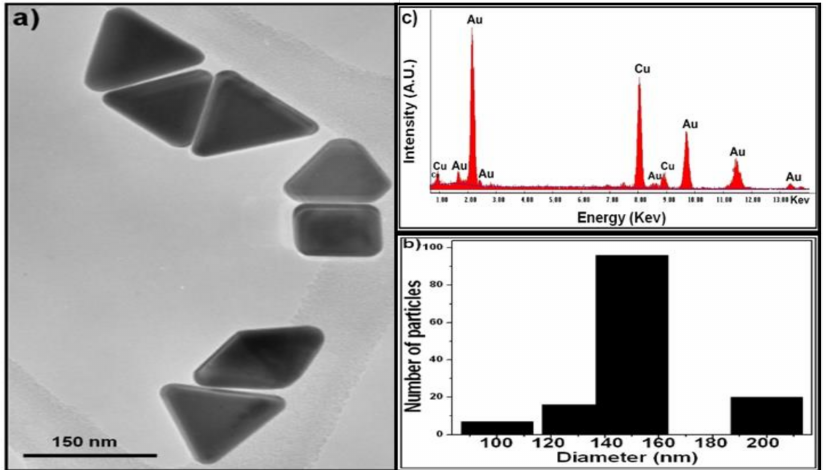
Figure 1. Characterization of AuNPs. ( a ) TEM image, ( b ) particle size distribution, and ( c ) EDX spectrum of triangular gold nanoprisms. Adapted with permission from [21], Copyright 2014 American Chemical